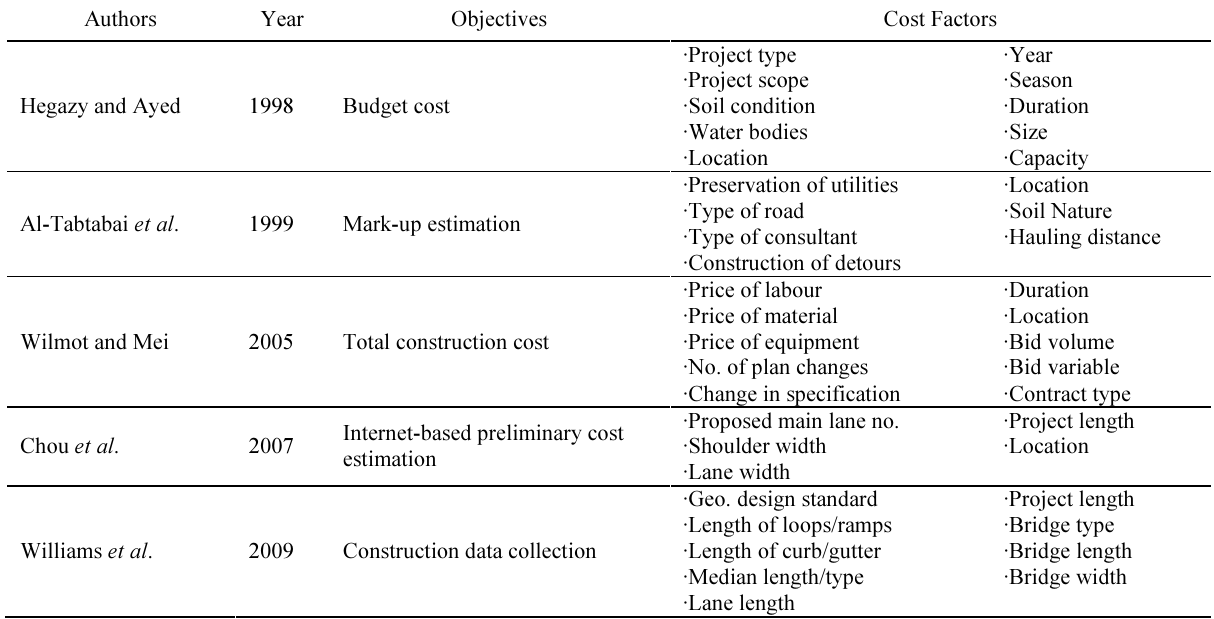
Table 2. Highway research and relevant